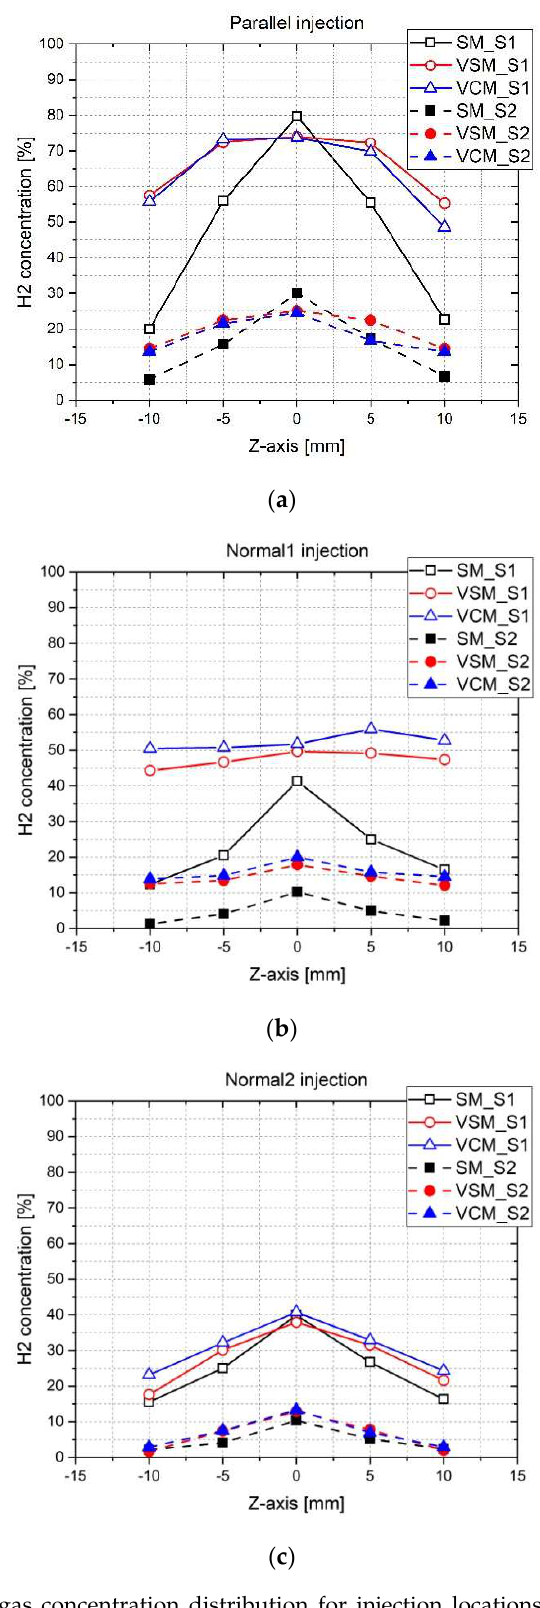
Figure 5. Hydrogen gas concentration distribution for injection locations: ( a ) parallel injection, ( b ) normal 1 injection, and ( c ) normal 2 injection (SM—step mixer, VSM—vent slot mixer, VCM—vent circle mixer, S1—span 1, S2—span 2).